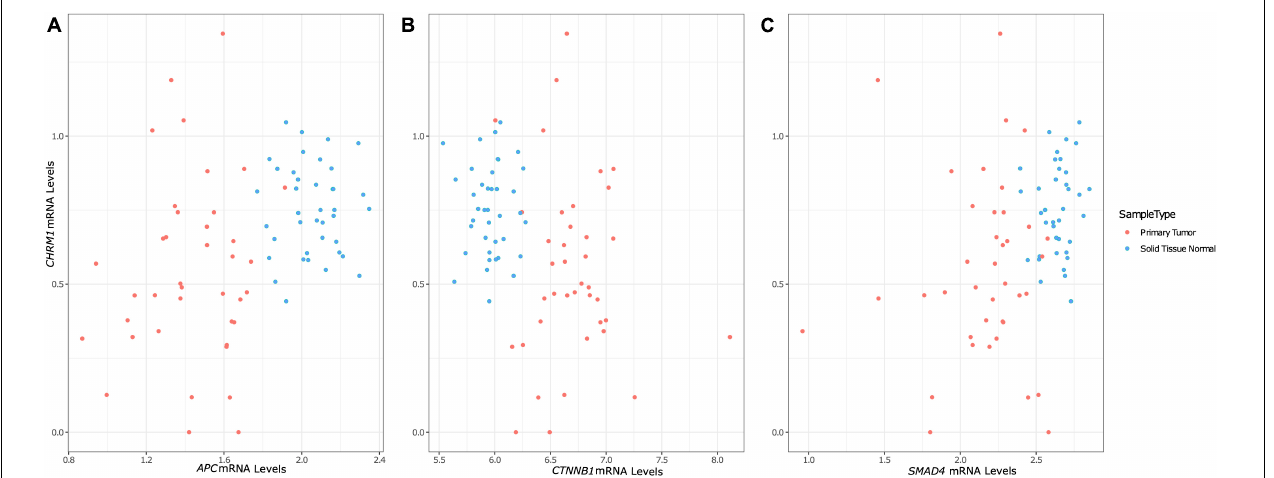
FIGURE 1 | Changes in CHRM1 mRNA expression levels are associated with changes in the expression levels of APC, CTNNB1, and SMAD4 . We used univariate mixed models with participant ID as a random effect to model processed (low count filtered, quantile normalized, log2 transformed, and batch corrected) CHRM1 expression data as a function of key genes in colorectal cancer. CHRM1 expression levels was significantly associated with APC (A) , CTNNB1 (encoding β -catenin) (B) , and SMAD4 (C) expression levels, which showed differential clustering of values based on cancer status.